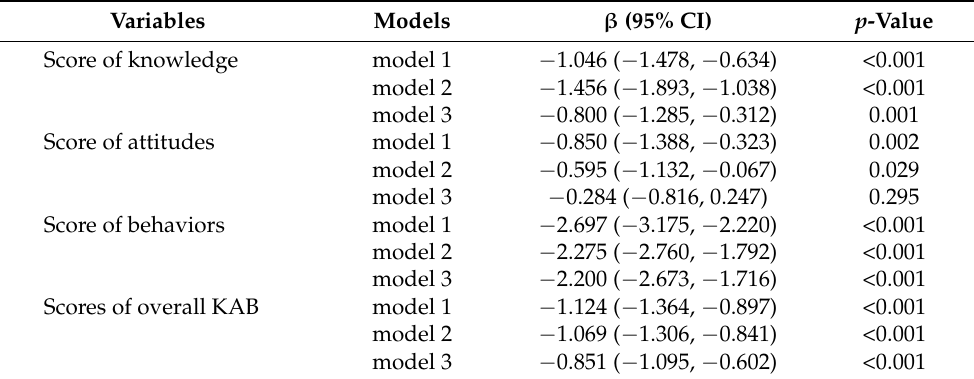
Table 6. Association between salt-related KAB scores and 24-h urinary sodium